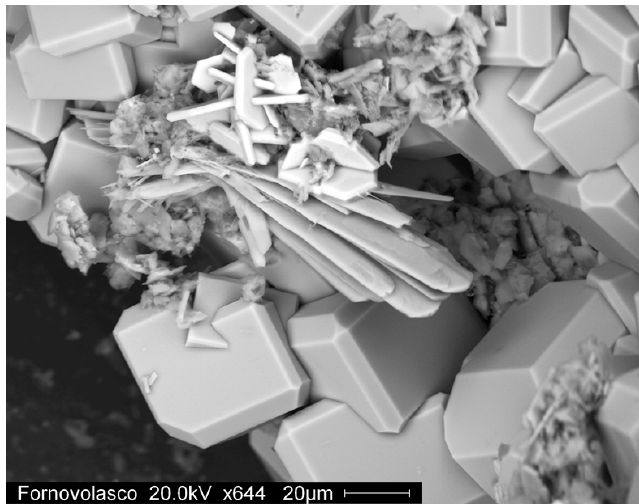
Figure 4. Alunogen from the Fornovolasco mine, as tabular crystals associated with voltaite, in cubic individuals, and an unknown tabular phase, bright in back-scattered electrons.